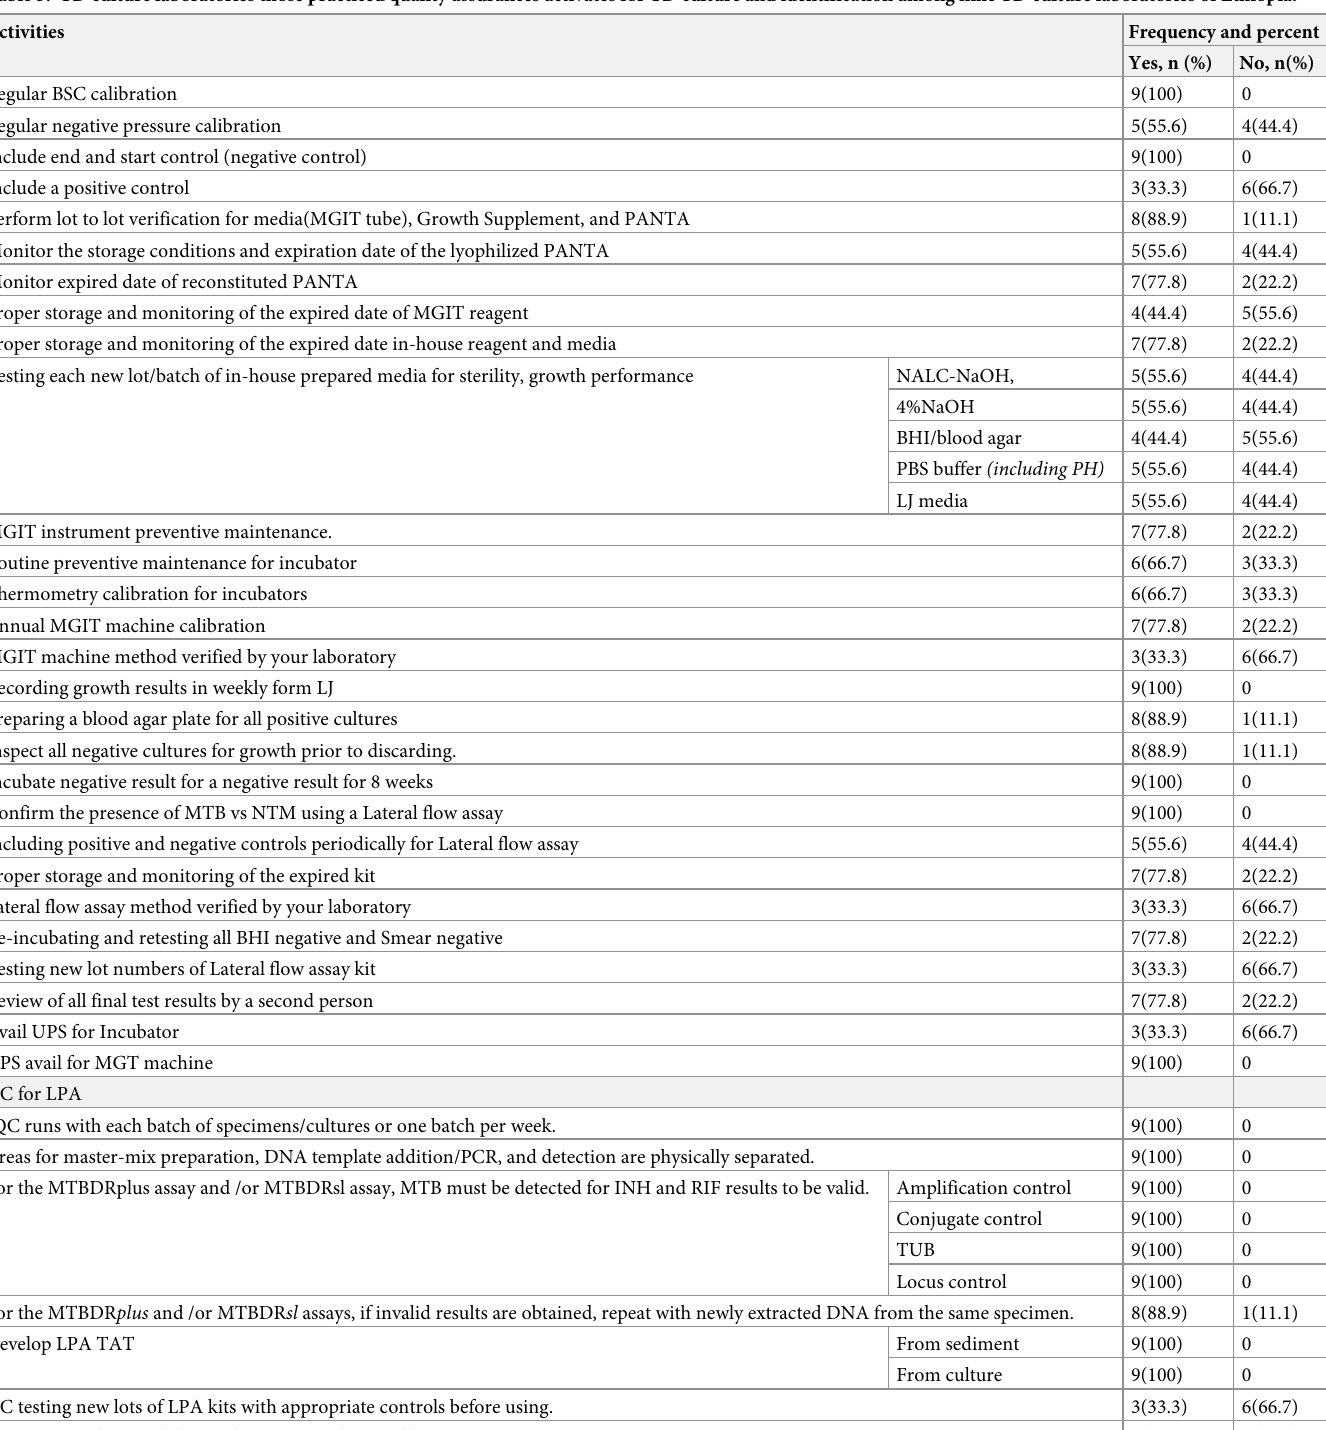
Table 3. TB-culture laboratories those practiced quality assurances activates for TB-culture and identification among nine TB-culture laboratories of